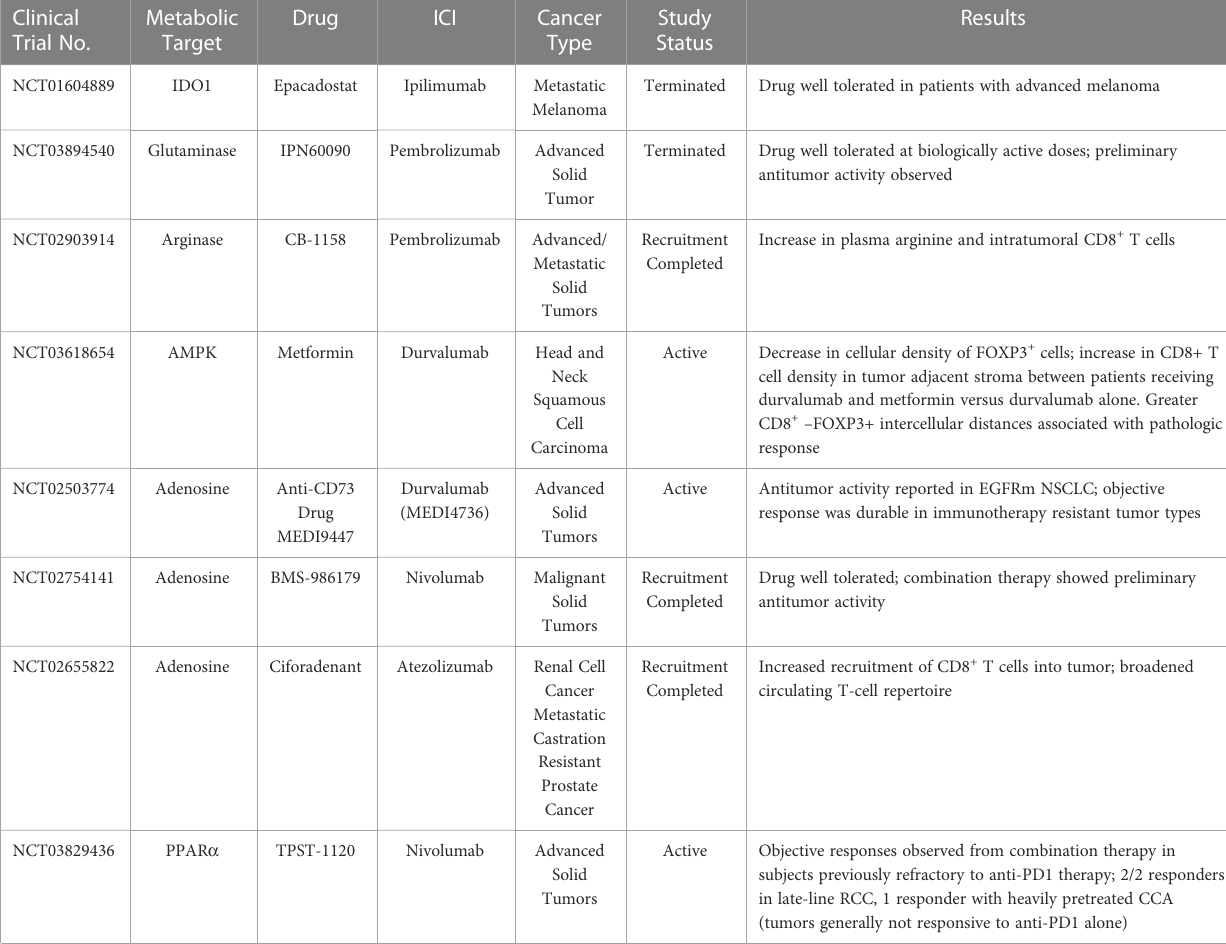
TABLE 2 Clinical trials of ICIs plus metabolic targets showing promising results. Clinical Trial